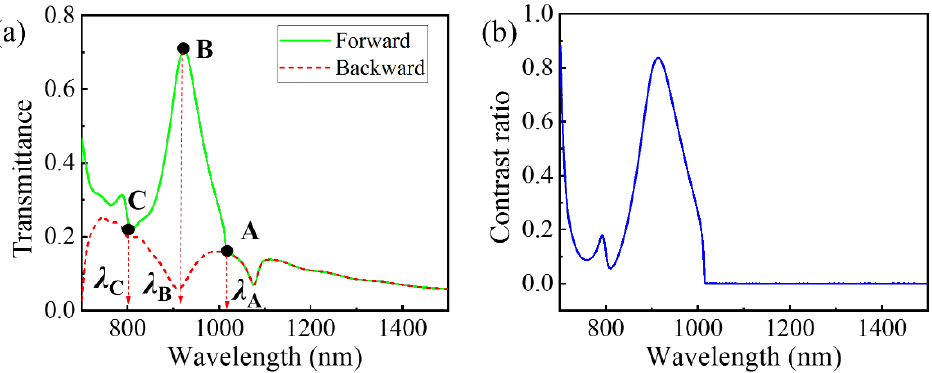
Figure 2. ( a ) Forward and backward transmittance spectra of the metasurface. ( b ) Contrast ratio versus wavelength. The marked wavelengths are λ A = 1017 nm at point A, λ B = 922 nm at point B, and λ C = 800 nm at point C.